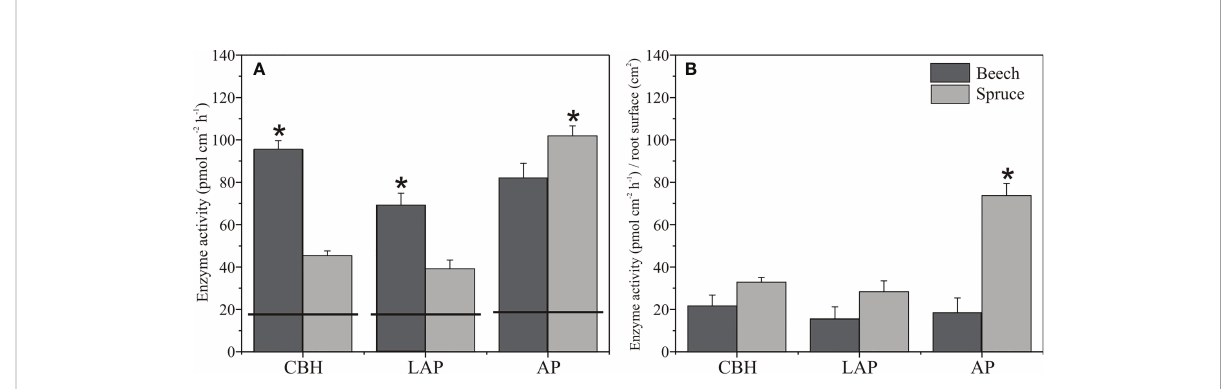
FIGURE 4 Enzyme activities in the rhizosphere of European beech and Norway spruce. Total (A) and root surface area-normalised (B) activity of cellobiohydrolase (CBH), leucine-aminopeptidase (LAP), and acid phosphomonoesterase (AP). The horizontal lines on the bars indicate the enzyme activities in the soil before tree planting. Bars represent mean values, and error bars represent standard error of the mean (N = 4). Asterisks indicate signi fi cant differences for means of enzyme activities between beech and spruce, p <